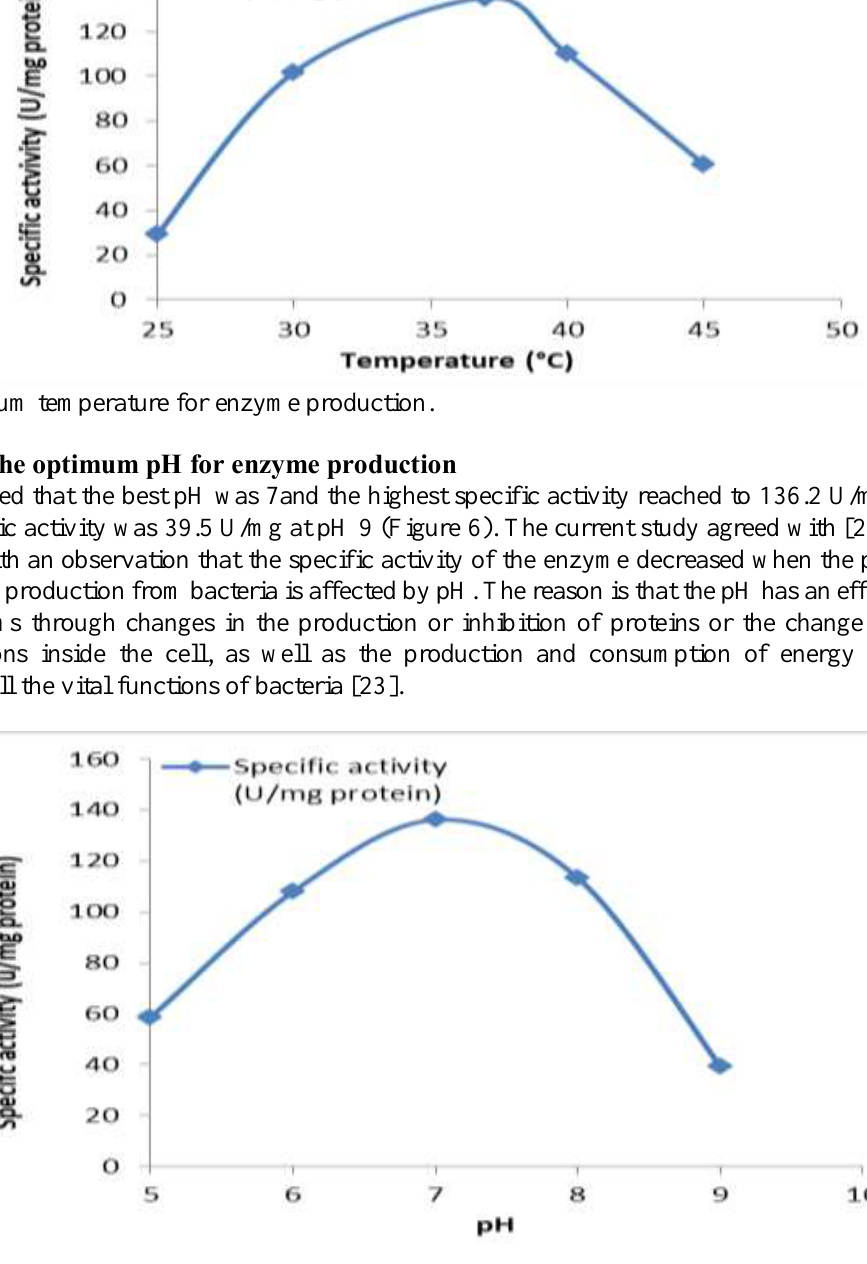
Figure 6: Optimum pH for enzyme production